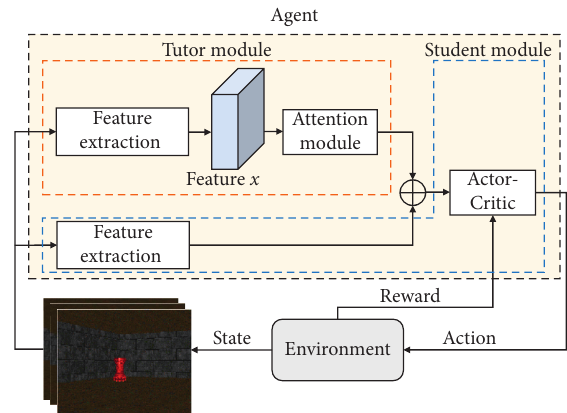
Figure 1: Pipeline of the attention-based